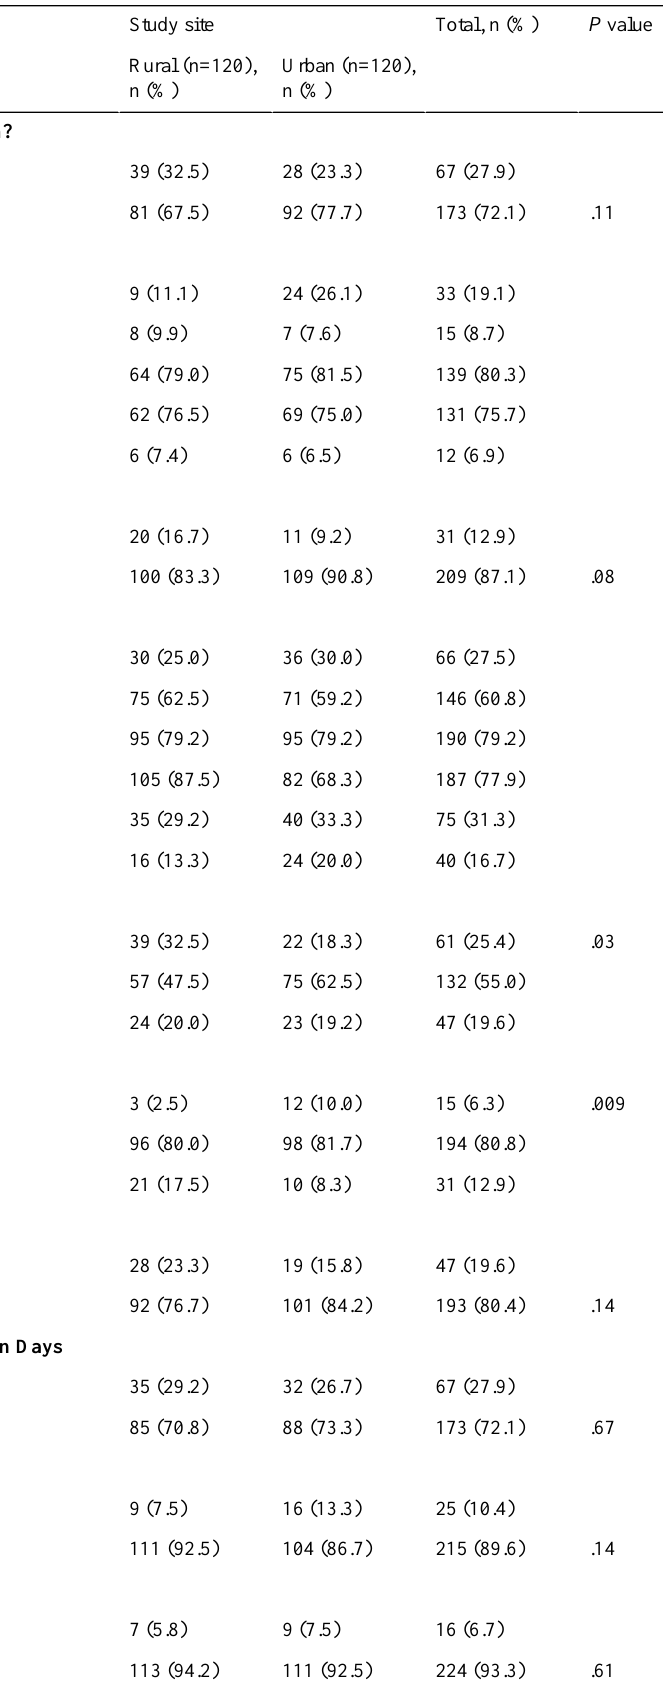
Table 3. Perceptions toward using mobile phones for health purposes. SMS: short message service.